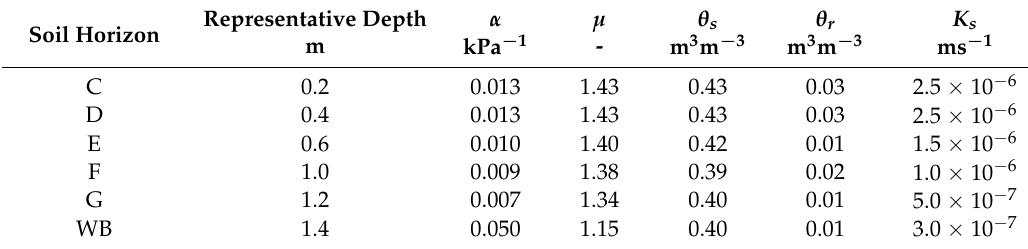
Table 2. Main hydrological properties of the soil at various levels.